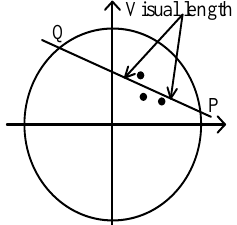
Figure 1. Correlation coefficient distribution